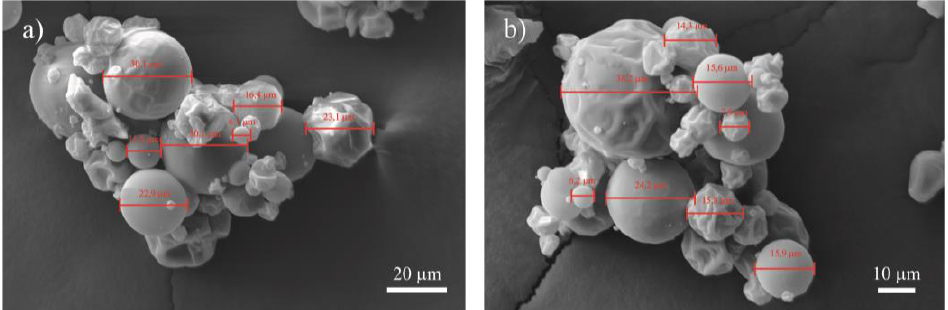
Figure 1. Scanning electron micrograph of microencapsulated propolis at different magnifications and particle diameters. ( a ) 1.57 K increase and ( b ) 1.94 K increase. and particle diameters. ( a ) 1.57 K increase and ( b ) 1.94 K